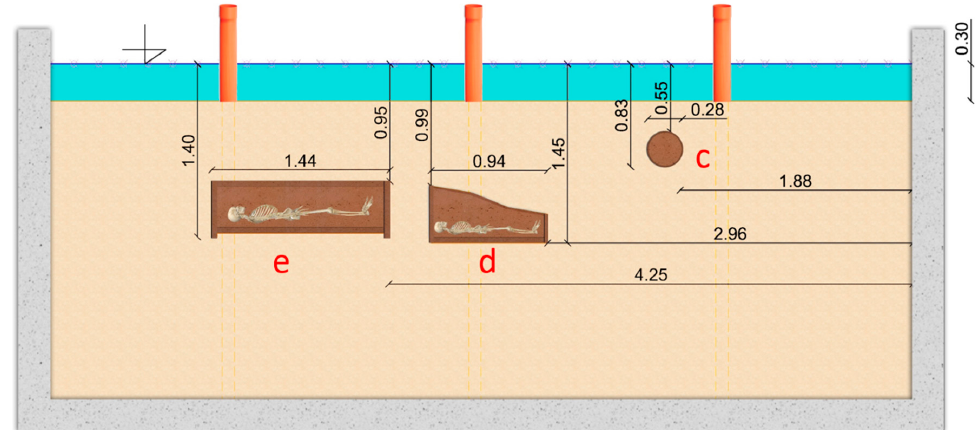
Figure 4. Transversal section realized on the line S2 with an indication of the size and depth of the buried objects.